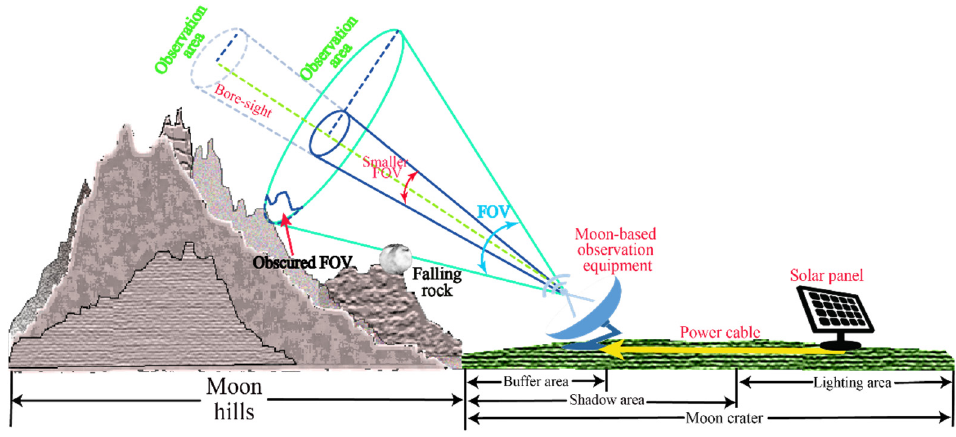
Figure 4. Observation performances of MBSEO (The figures are made by Adobe Illustrator, a vector graphics software).